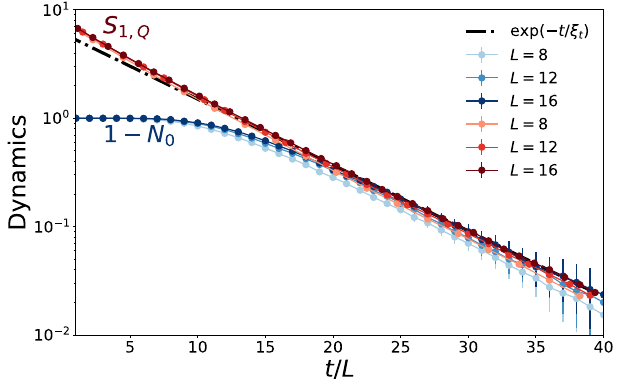
FIG. 16. Critical dynamics of charge-sharpening transition in qubit chains. Comparison of the dynamics of the ancilla entan- glement entropy S 1 and the quantity 1 − N 0 , where N 0 is the ;Q fraction of trajectories with δ Q 2 < 0 . 01 and the ancilla entan- glement entropy S 1 . After rescaling the overall amplitude, both ;Q observables collapse to the same exponential function in the longtime limit.